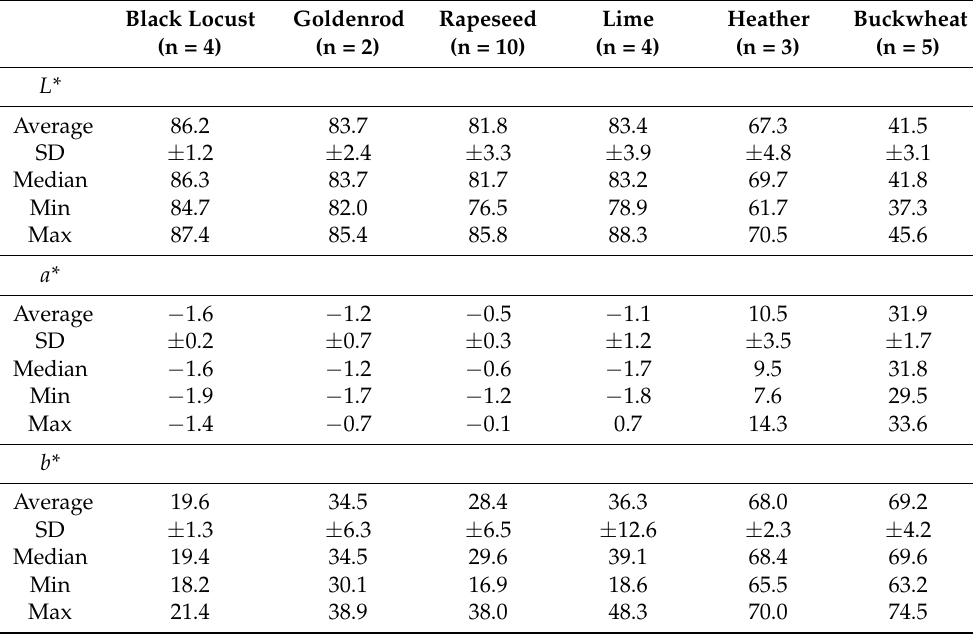
Table 16. Color parameters of Polish unifloral